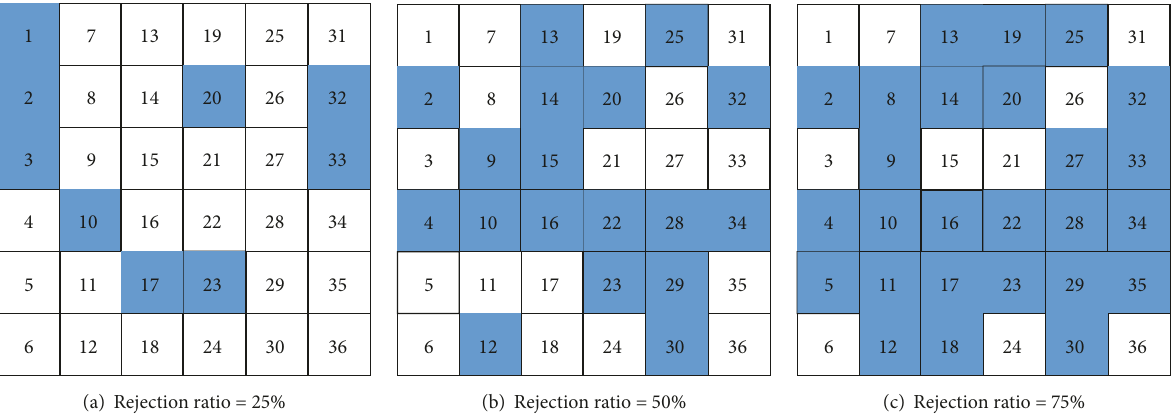
Figure 11: Schematic diagram of design variables in GA optimization